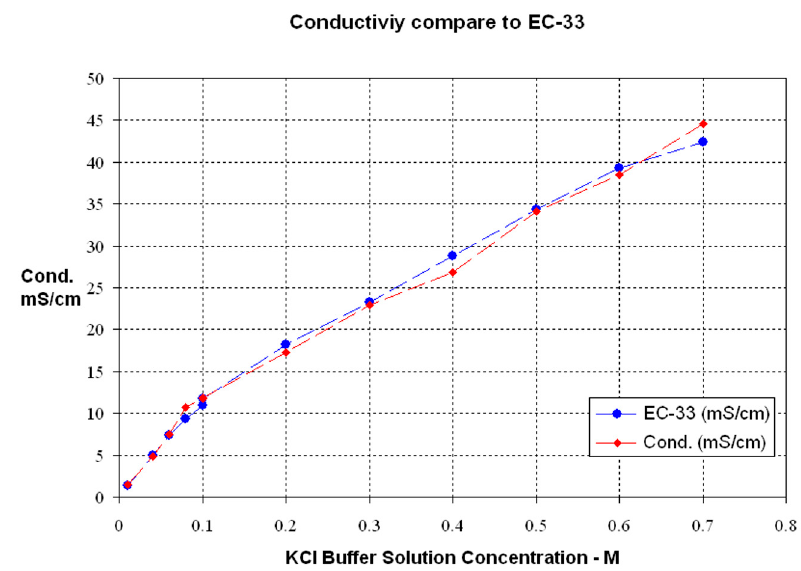
Figure 18. Conductivity measurement results compared with a commercial device.